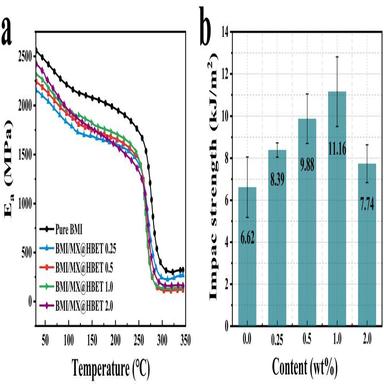
(a) Storage modulus and (b) impact strength of BMI and its composites.